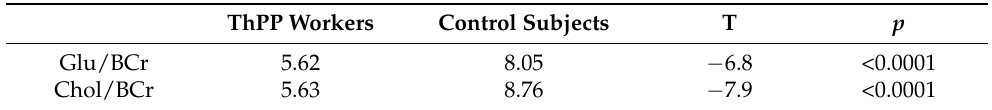
Table 2. A comparison of the biological markers glucose, cholesterol, and triglycerides to the trace elements ratios of the study group (ThPP workers, n = 70) and the control group ( n = 30). ThPP Workers Control